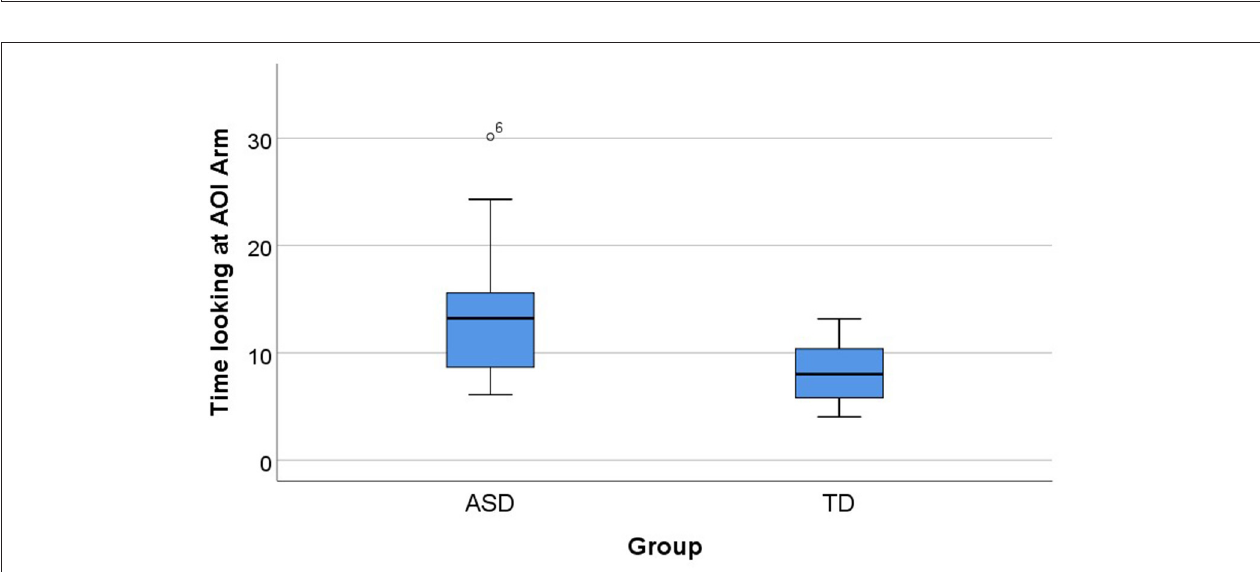
FIGURE 7 | Group differences in the social salient cue condition. (A) Total time for ASD and TD groups for the social salient cue condition. (B) Head rotation for ASD and TD groups for the social salient cue condition. Boxplots: central mark—median; edges of box − 25th and 75th percentiles; whiskers—most extreme data points (minimum and maximum). ASD, autism spectrum disorder group; TD, typical neurodevelopment group. The symbol * is the representation of an extreme outlier.